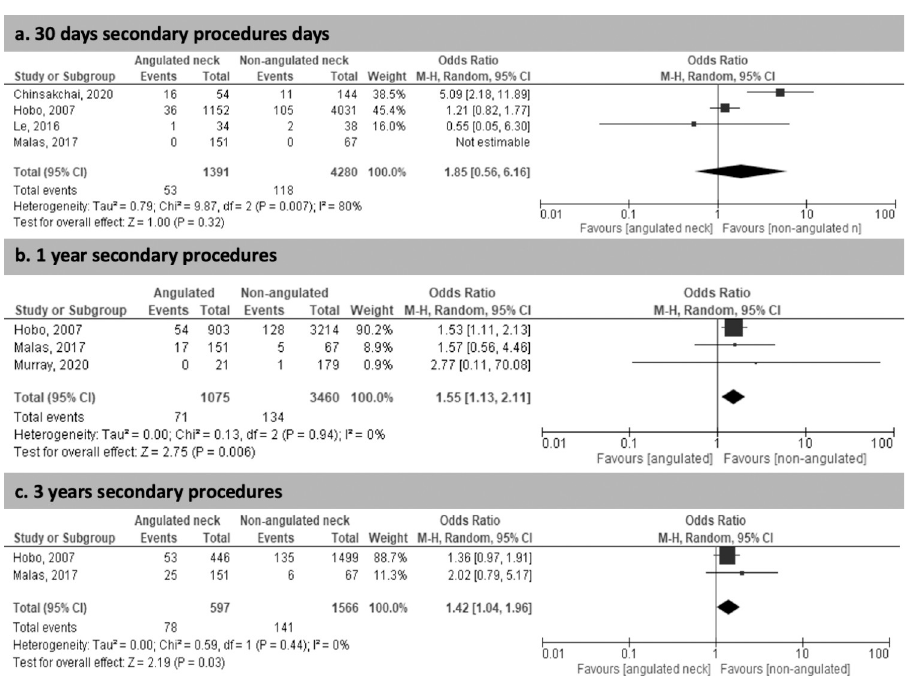
Fig 3. Rate of neck related secondary procedures. Rate of neck related secondary procedures at 30 days (a), 1 year (b) and 2 years (c).